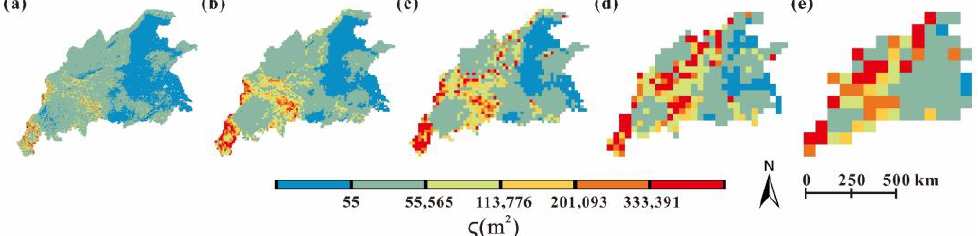
Figure 8. Spatial distribution for the sill value ς of the DEM semi-variogram: The spatial resolution is 10 km ( a ), 20 km ( b ), 40 km ( c ), 80 km ( d ), and 160 km ( e ).